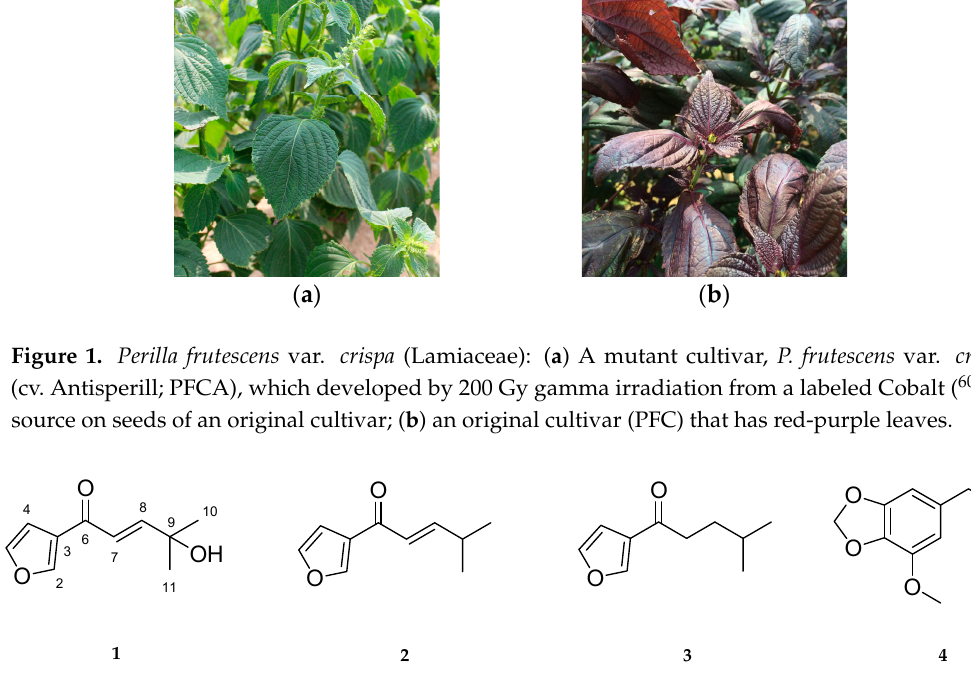
Figure 2. Chemical structures of compounds from the SC-CO 2 extracts of PFCA and PFC.